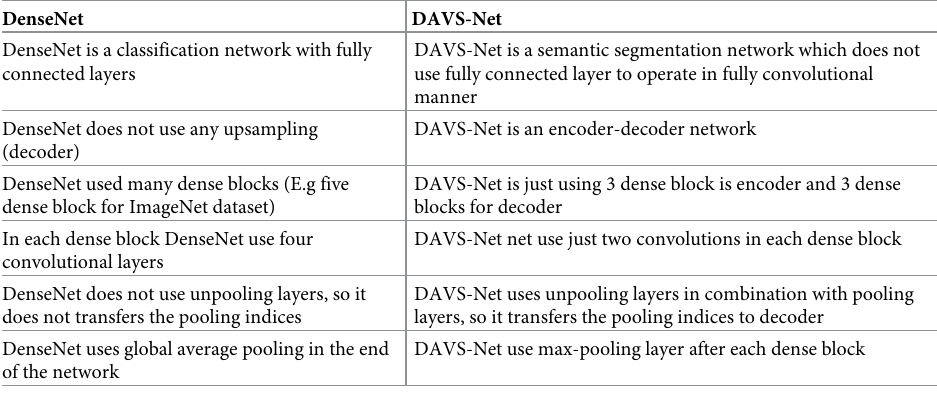
Table 1. Difference between DenseNet and proposed